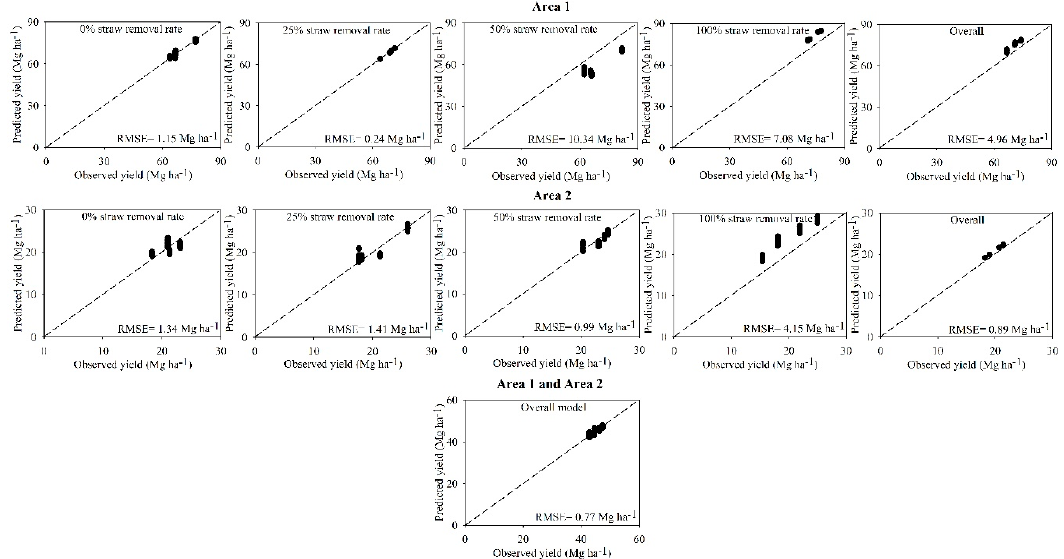
Figure 10. Comparison of sugarcane yield observed with predicted values with Stepwise models. The diagonal dashed line is the 1:1 line, whereas RMSE is the root mean square error.